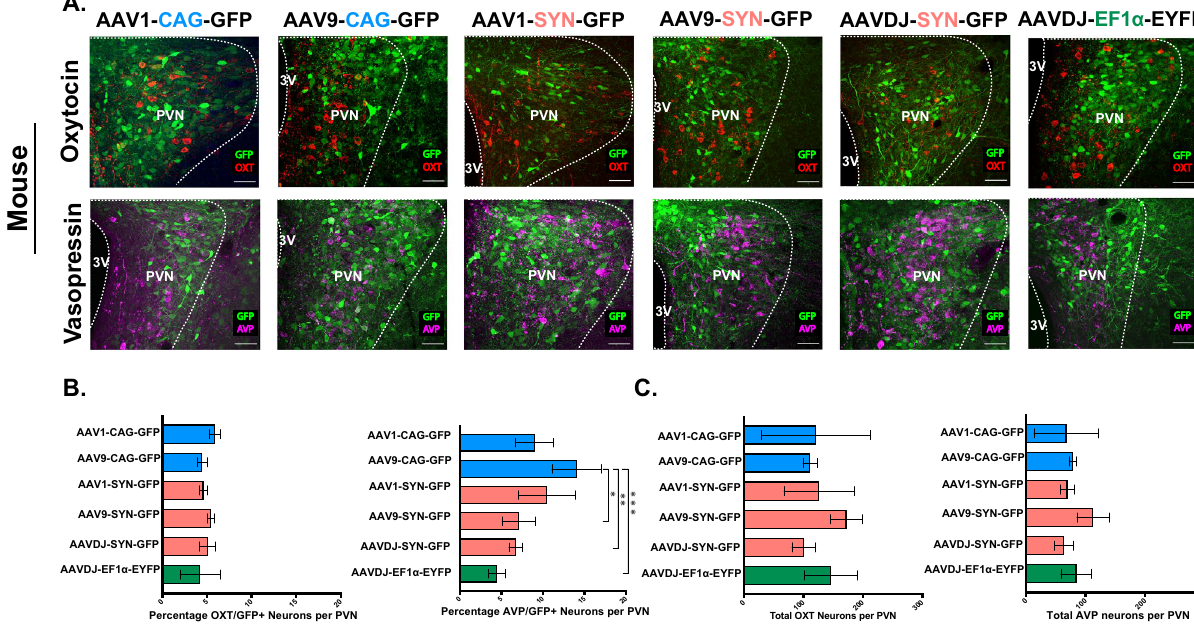
Figure 2. Transduction efficiency of different combinations of adeno-associated viral (AAV) serotypes and promoters in oxytocin (OXT) and vasopressin (AVP) neurons of the hypothalamic paraventricular nucleus (PVN) of adult mice. ( A ) Confocal images of mice brain tissues, three weeks following viral injection in the PVN and immunoblotting with anti-OXT (red, top panel) or anti-AVP (magenta, bottom panel). GFP is encoded by the virus (green, top and bottom panels). 40×, Scale bar = 50 μm, dotted line demarcates the PVN and the 3rd ventricle; 3 V. ( B ) Bar graphs (± SEM) show the average percentage of OXT positive (OXT+, left) or AVP positive (AVP+, right) neurons that also express the virus (GFP+) in the PVN. Low percentages, reflecting low transduction efficiency, were observed across all viruses in both OXT and AVP neurons, with the highest efficiency observed when using the CAG promoter. ( C ) Bar graphs (± SEM) show the total number of OXT (left) or AVP (right) neurons per mouse PVN. n = 3 mice per virus with an average of 5 slices per mouse PVN.